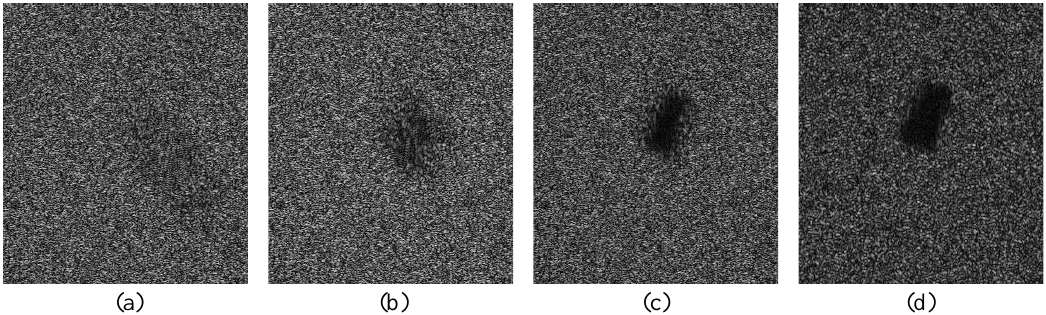
Figure 11. Effect of synthetic aperture time on shadow (horizontal is azimuth; vertical is range). Target speed is ( 5 × 5 ) m/s, aperture size is 800 m and carrier frequency is 16 GHz; ( a )2 s, ( b )1 s ( c ) 0.5 s, ( d ) 0.3